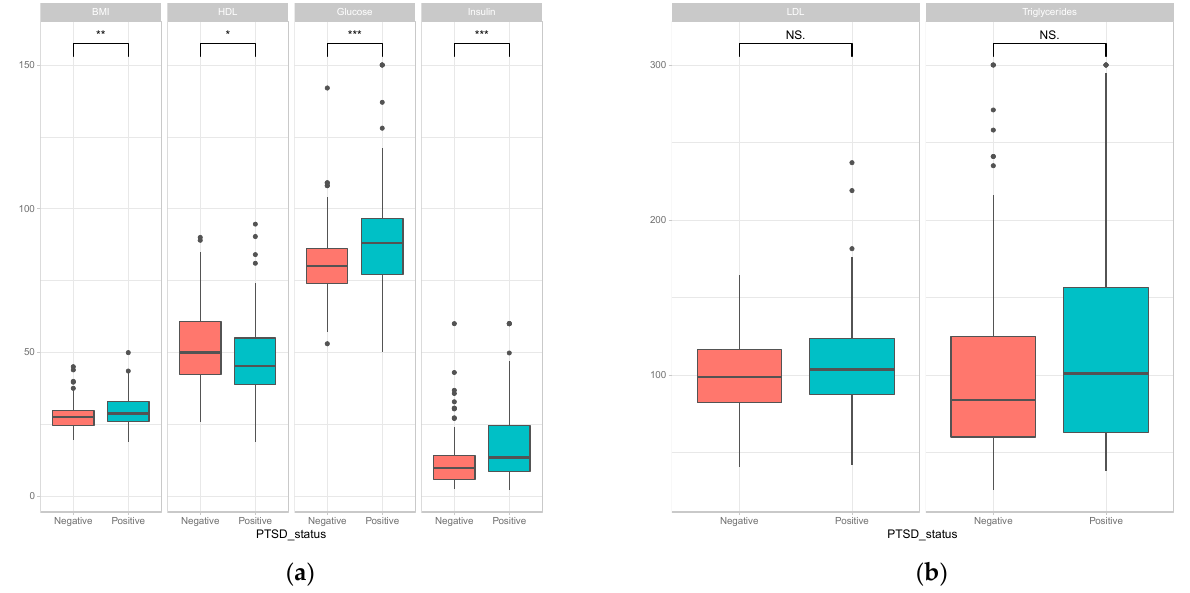
Figure 2. Comparing levels of components of MetS between PTSD cases and healthy controls. ( a ) Some MetS components show statistical difference between PTSD cases and healthy controls. ( b ) Some MetS components show change in the expected direction between PTSD-positive cases and PTSD-negative controls but not at statistically significant level. (***: p < 0.0001, **: p < 0.01, *: p < 0.05, NS: p > 0.05).